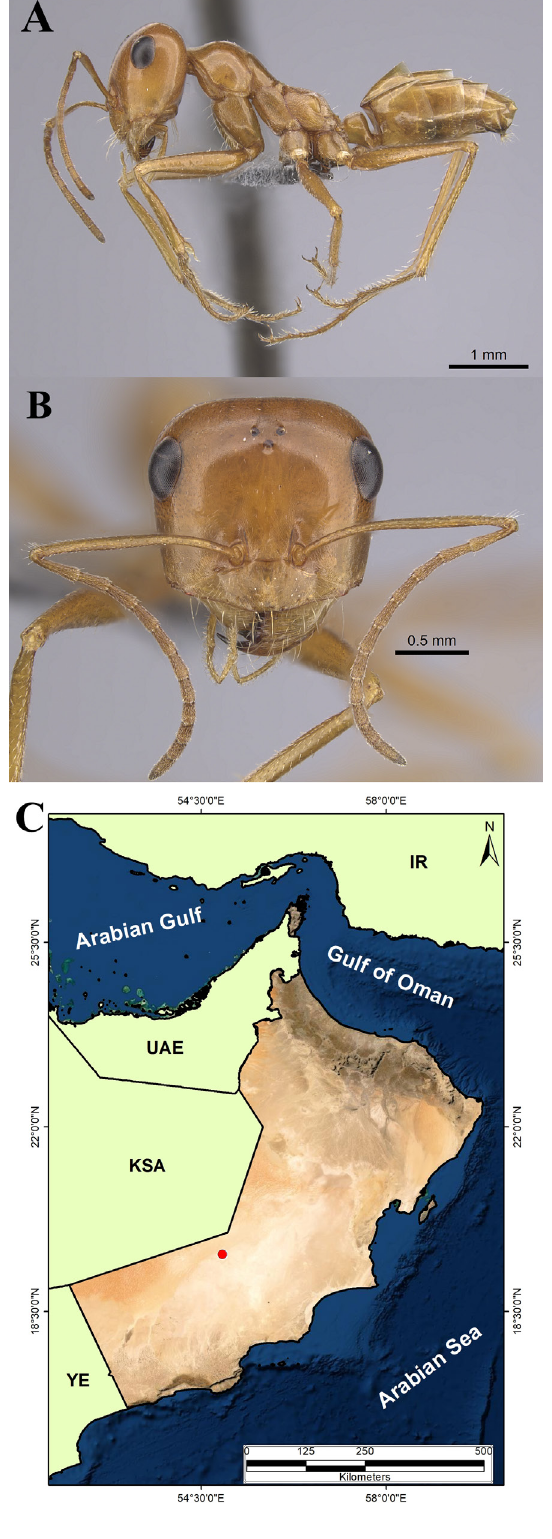
Fig. 10. Cataglyphis arenaria Finzi, 1940, worker (CASENT0263825, AntWeb.org (Will Ericson)). A . Body in profile. B . Head in full-face view. C . Distribution